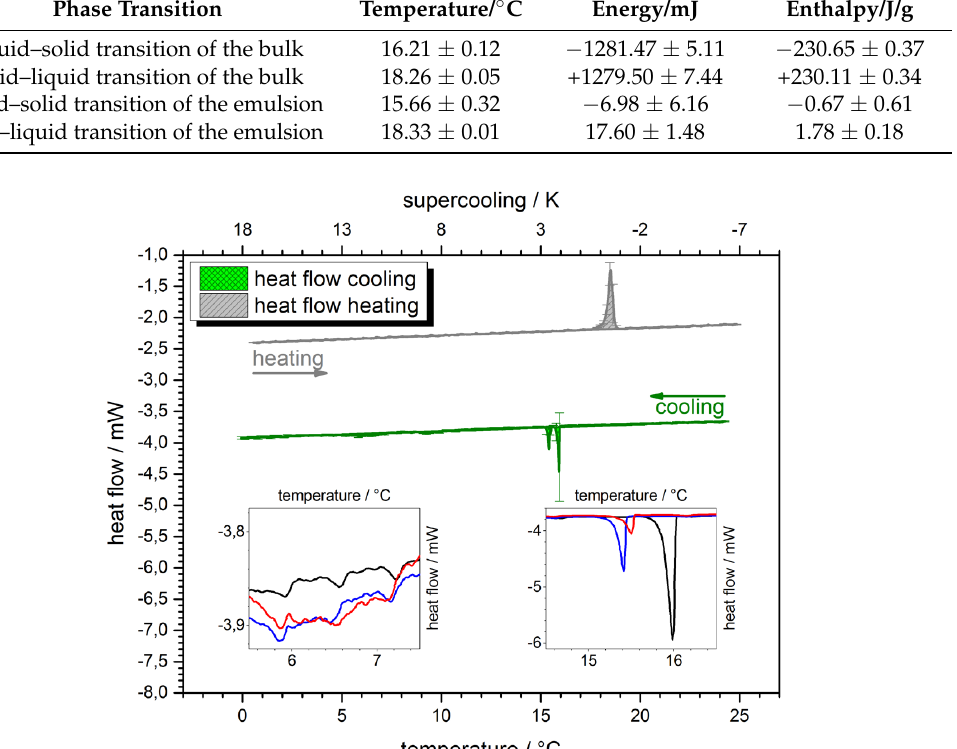
Figure 4. DSC measurements of 1 wt % hexadecane in Milli-Q water emulsions stabilized with 1 wt % Tween ® 20. Cooling from 25 to 0 °C with cooling rate of 1 K/min: grid area is the integral of cooling curve and standard deviation of the repetitions. Heating from 0 to 25 °C with heating rate of 1 K/min: hatched area is the integral of heating curve and standard deviation of the repetitions. The outlined region from 15 to 16 °C on the right shows the major crystallization peaks of the measured emulsion. The outlined region from 6 to 7 °C on the left shows magnified cooling curves of the measured emulsions.